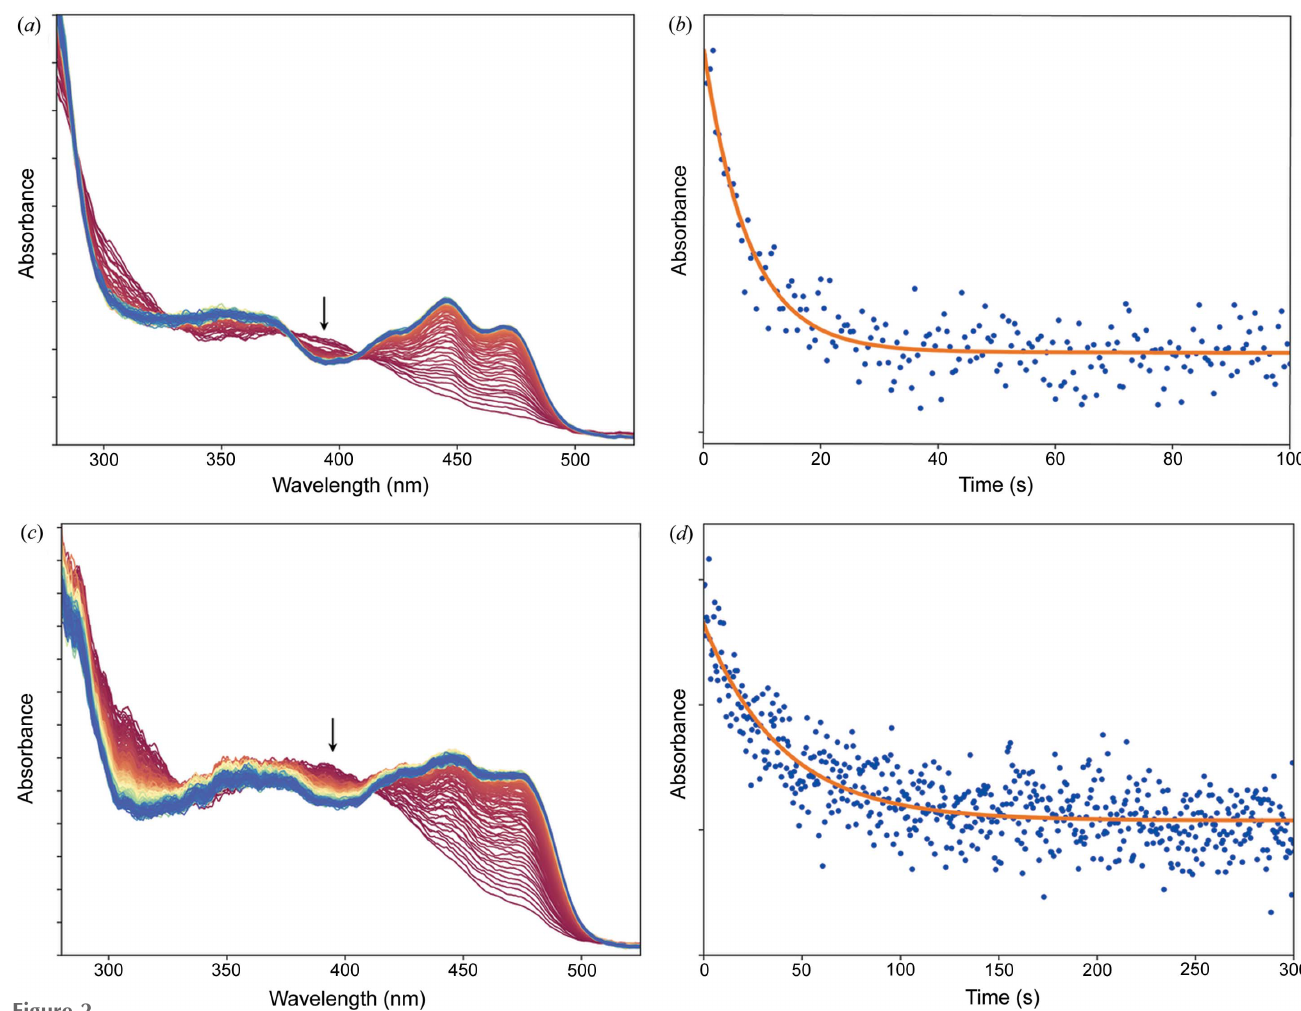
Figure 2 PS equilibrium relaxation monitored by UV–Vis absorption spectroscopy. ( a ) Time-dependent series of spectra recorded at 2 Hz from 0 s (red spectra) to 100 s (blue spectra) after the end of blue-light illumination of a solution of LOV2. ( b ) Time evolution of the absorbance at 390 nm of the solution spectra shown in ( a ), modelled with a monoexponential decay (red curve) with (cid:3) = 6.0 s. ( c ) Time-dependent series of spectra recorded at 2 Hz from 0 s (red spectra) to 300 s (blue spectra) after the end of blue-light illumination of a crystal of LOV2. ( d ) Time evolution of the absorbance at 390 nm of the solution spectra shown in ( c ), modelled with a monoexponential decay (red curve) with (cid:3) = 40